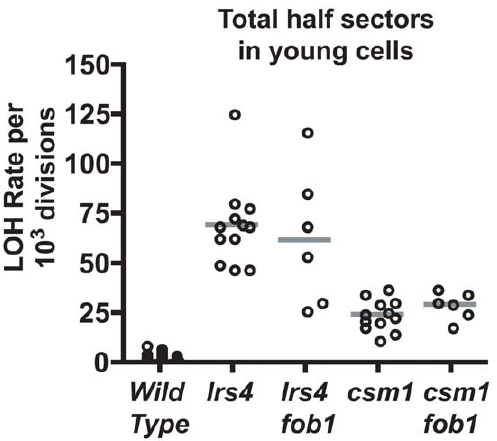
Figure 5. Double mutant analysis of fob1 and cohibin mutants. Scatter plots of total LOH rates at the MET15 locus in young cells with genotypes as indicated.